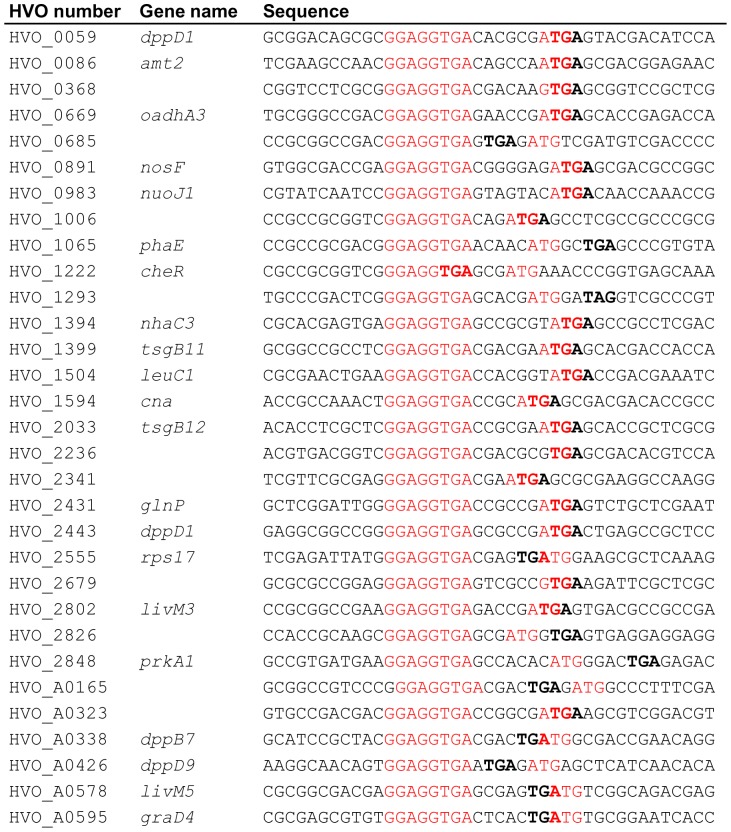
Spacing between the 8 nt SD motif to the start codon of the downstream gene.In 31 cases the extended 8 nt SD motif was found to be localized at the 3′-end near the stop codon. The sequences around the SD motif were retrieved from the genome sequence of H. volcanii and the gene identifier (HVO numbers) and sequences are shown. It turned out that all 31 genes were proximal genes in operons and were closely followed by a downstream gene. The SD motif and the start codon of the downstream gene are shown in red, and the stop codon of the upstream gene is shown in bold.